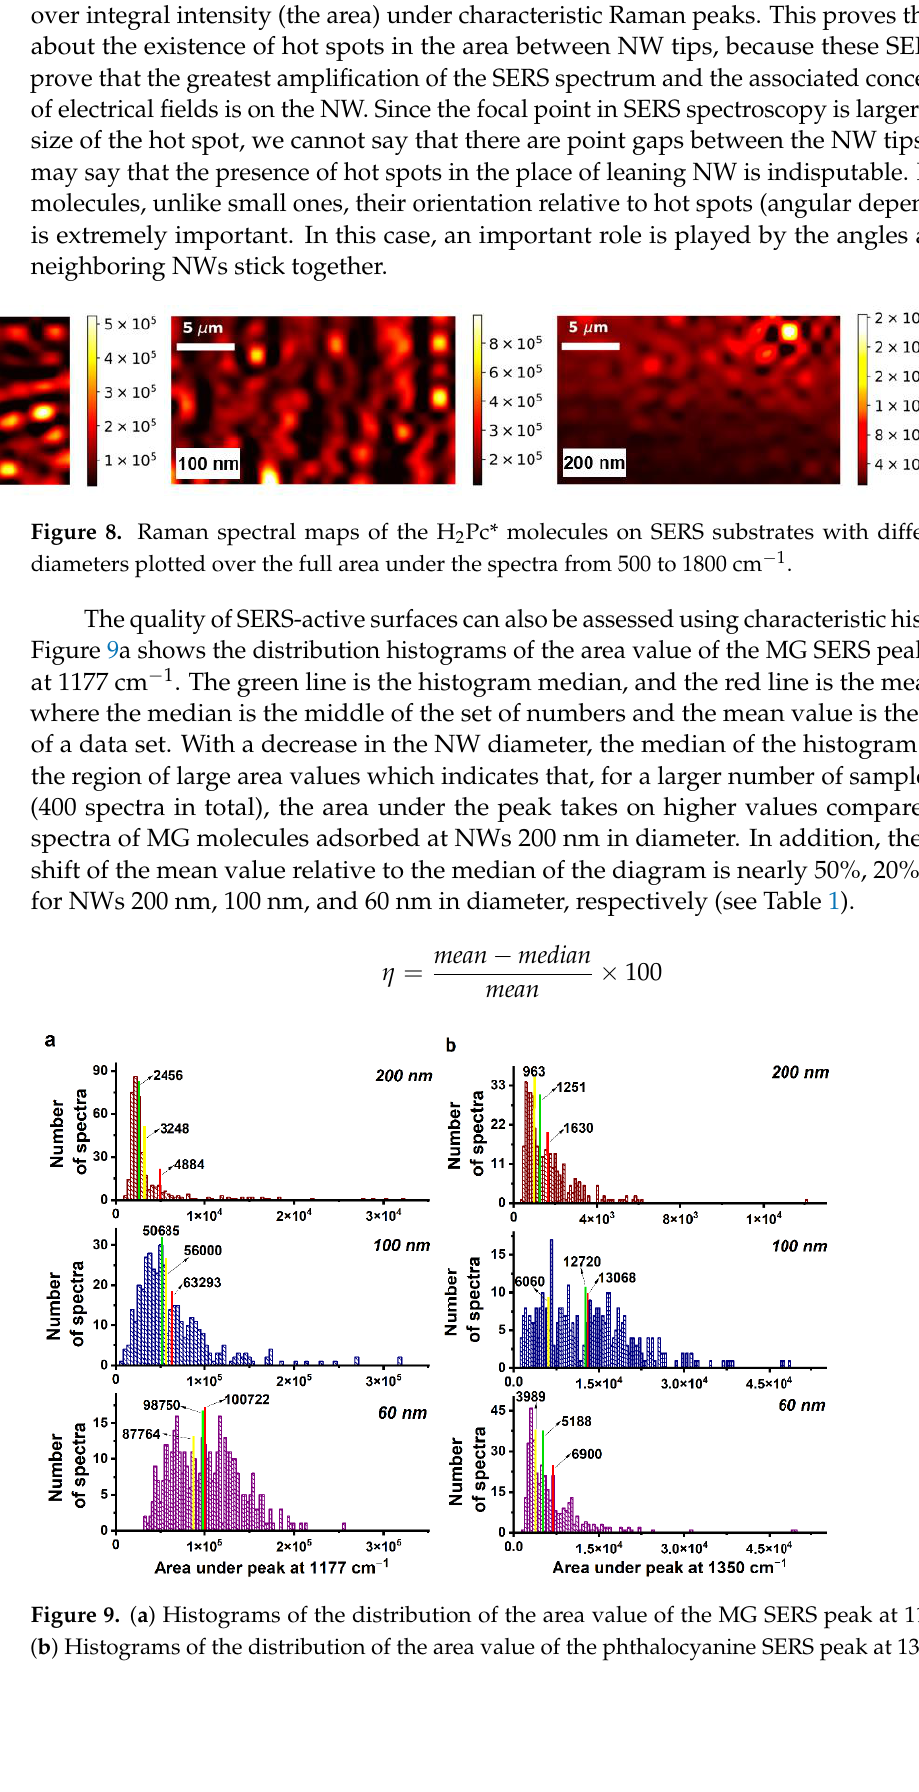
12 of 21 Figure 7. Optical microscopy images of SERS substrates with different NW diameters of 60, 100 and 200 nm (top line of images). SERS-mapping of H 2 Pc* (10 mM) adsorbed on substrates with NWs of 60, 100 and 200 nm in diameter, plotted in accordance with integral intensity (the area) under three characteristic Raman peaks (1175, 1350 and 1600 cm −1 ). It is obvious that, in contrast to small MG molecules, patterns for different Raman